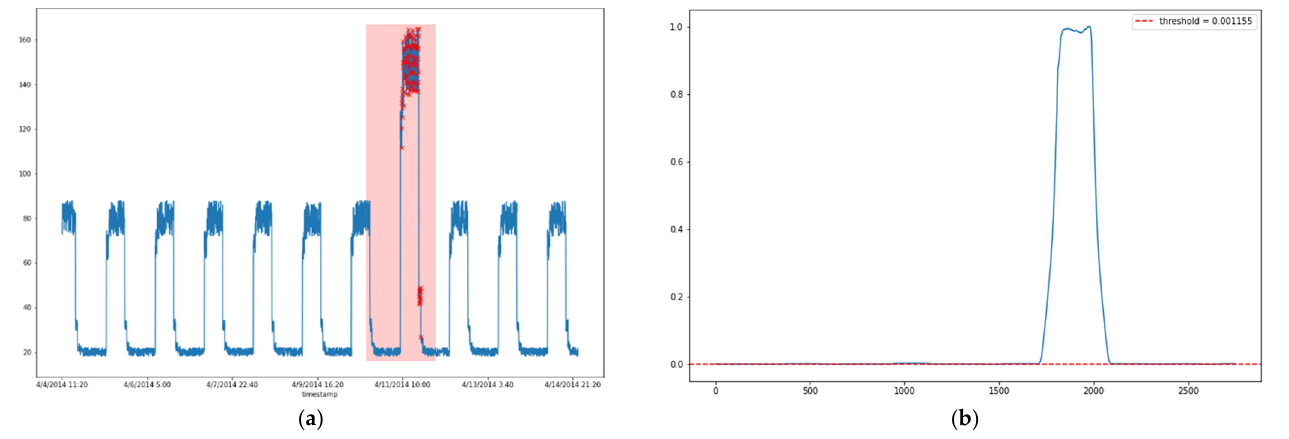
Figure 5. Anomaly detection by our SSL method for NAB Artificial With Anomaly dataset. ( a ) Anomaly points with original NAB Artificial With Anomaly dataset; ( b ) anomaly score with threshold.